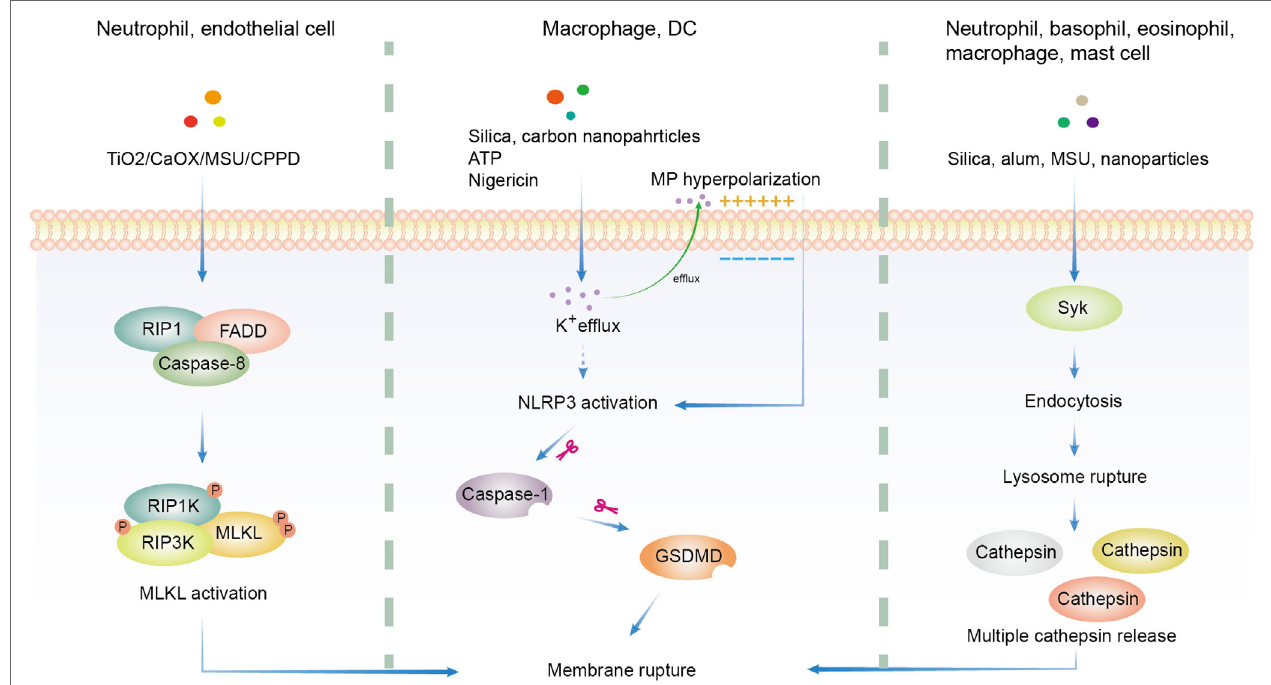
FiGURe 2 | Overview of three major hypotheses of solid particle-induced cell death. In addition to cell death related to reactive oxygen species production, there are three major proposals on solid particle-induced cell death. The first is through receptor-interacting serine/threonine-protein kinase 1/3 (RIPK1/RIPK3)- mixed lineage kinase domain-like (MLKL)-driven necroptosis, which was found in calcium oxalate, monosodium urate (MSU), calcium pyrophosphate dihydrate (CPPD), cystine, TiO 2 , and calcium phosphate-treated epithelial cells and neutrophils. The second is through K + efflux-activated NACHT, LRR, PYD domains- containing protein 3 (NLRP3)-dependent pyroptosis, which was found in silica, asbestos, carbon nanoparticles-treated macrophages and dendritic cells (DCs). The third is through lysosome rupture-released multiple redundant cathepsins after Syk-dependent phagocytosis, which was found in silica, alum, MSU, and nanoparticle-treated neutrophils, basophils, eosinophils, macrophages, and mast cells. GSDMD, gasdermin